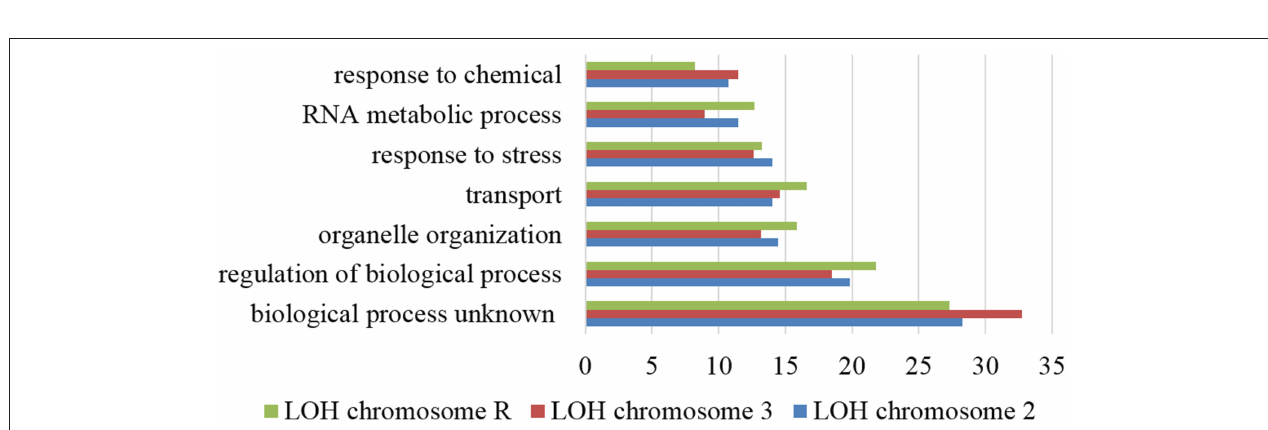
FIGURE 4 | Gene ontology process terms. All genes affected by LOH regions of chromosome 2, 3, and R identified in the evolved strains. Data is relative to non-evolved strains. The graph represents the percentage of genes affected in each process above 10%.